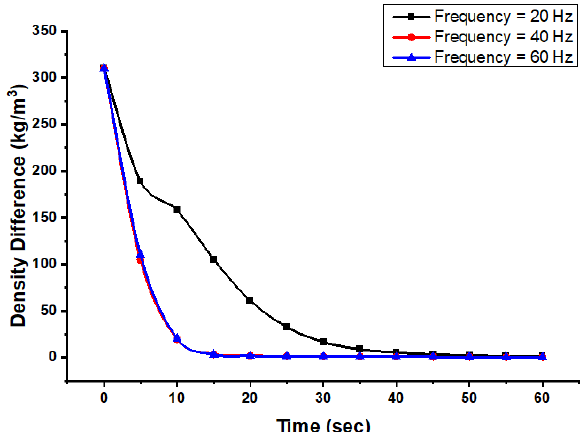
Figure 13. Mixing efficiency comparison based on frequency.